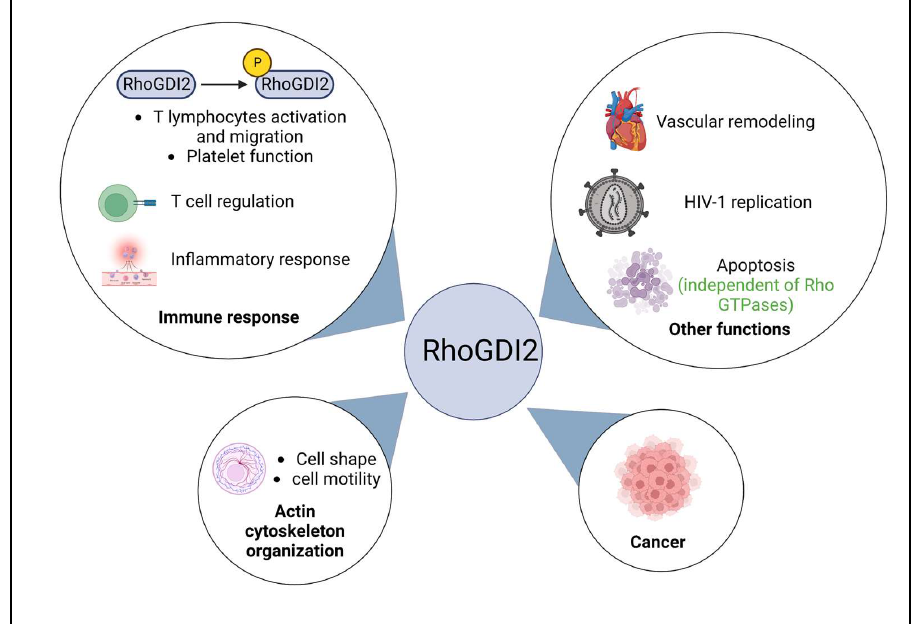
Figure 3. Schematic representation of the main functions of RhoGDI2 in the human body. RhoGDI2